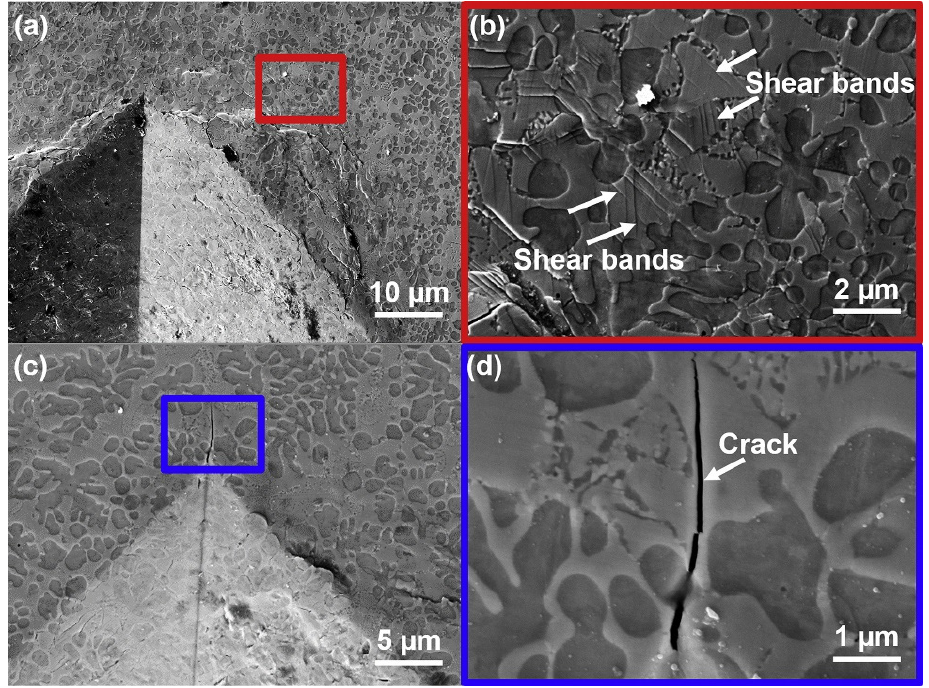
Figure 38. FeCrMoBC BMGC by DED, ( a , b ) higher cooling rate and ( c , d ) lower cooling rate. Re- produced from [100], with permission from Elsevier, 2021.